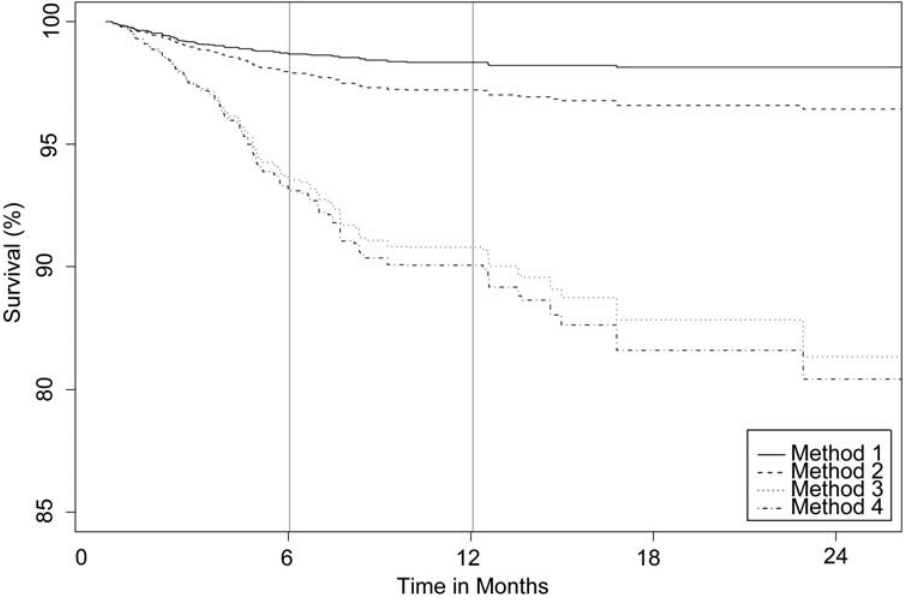
Figure 2. Kaplan-Meier estimates of patient survival based on methods described in Table 3. Time is in months since start of CART.